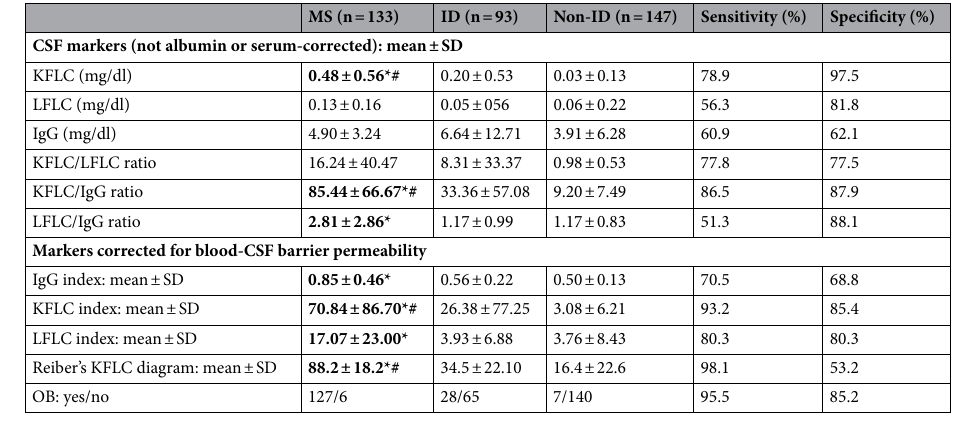
Table 1. Absolute concentrations of kappa (K) and lambda (L) free light chains (FLC), CSF ratios and indexes were determined in multiple sclerosis (MS), inflammatory neurological diseases other than MS (ID), and non-ID. Values are expressed in mean ± standard deviation (SD). We included 373 patients for KFLC and oligoclonal bands (OB) evaluation, 223 of them were tested also for LFLC. OB yes/no: “yes” was intended for types II (OB exclusively in CSF and not in serum) and III (contemporary presence of OB in both CSF and serum with a clear predominance in CSF). *Means significantly different in MS from ID and non-ID (p < 0.005 was considered significant according to Bonferroni correction for multiple comparisons). # Means significantly different among three groups (MS versus ID versus non-ID, p <